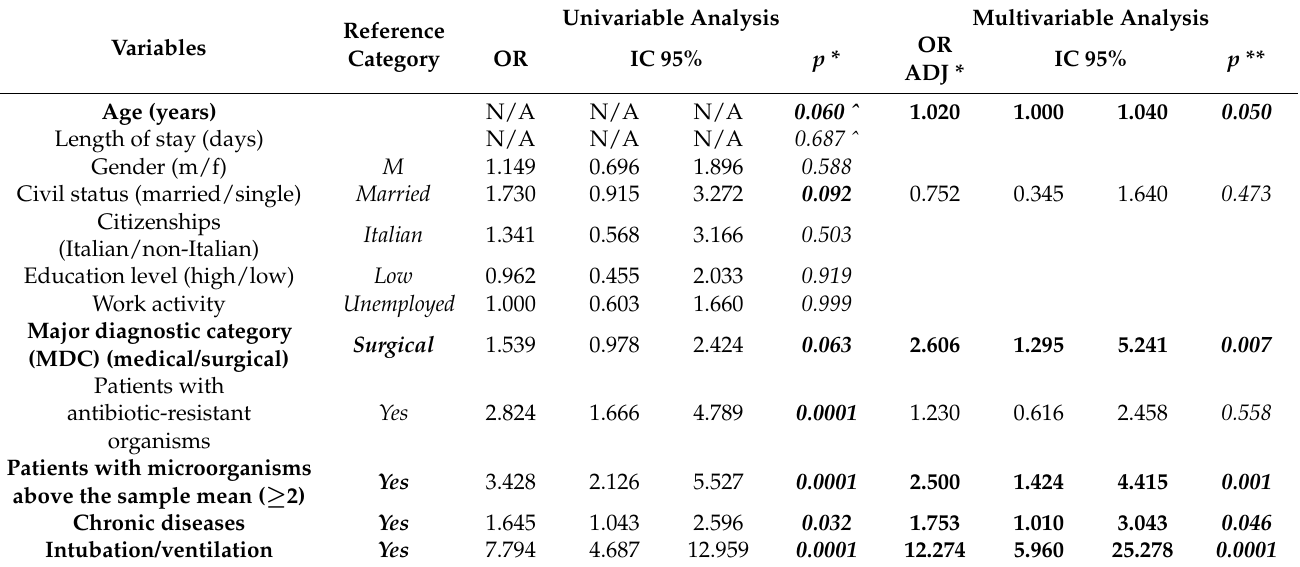
Table 3. Crude and adjusted OR (and 95% CI) of death, according to relevant variables.